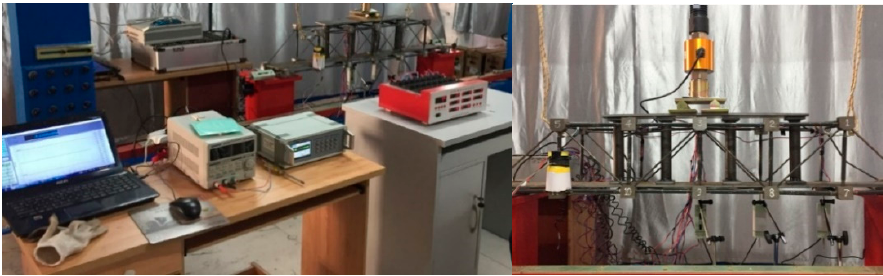
Figure 10. Magnetic stress sensing system for steel truss structures.